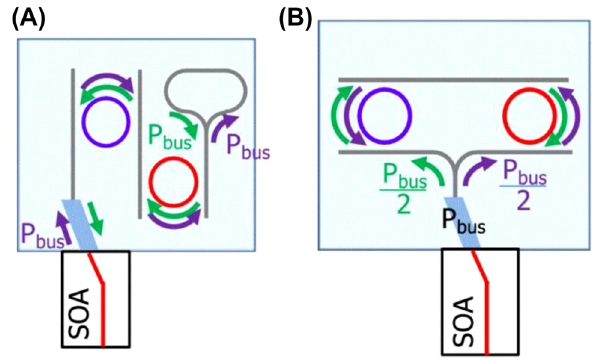
Figure 10: (A) Series double-loop structure. (B) Parallel double-loop